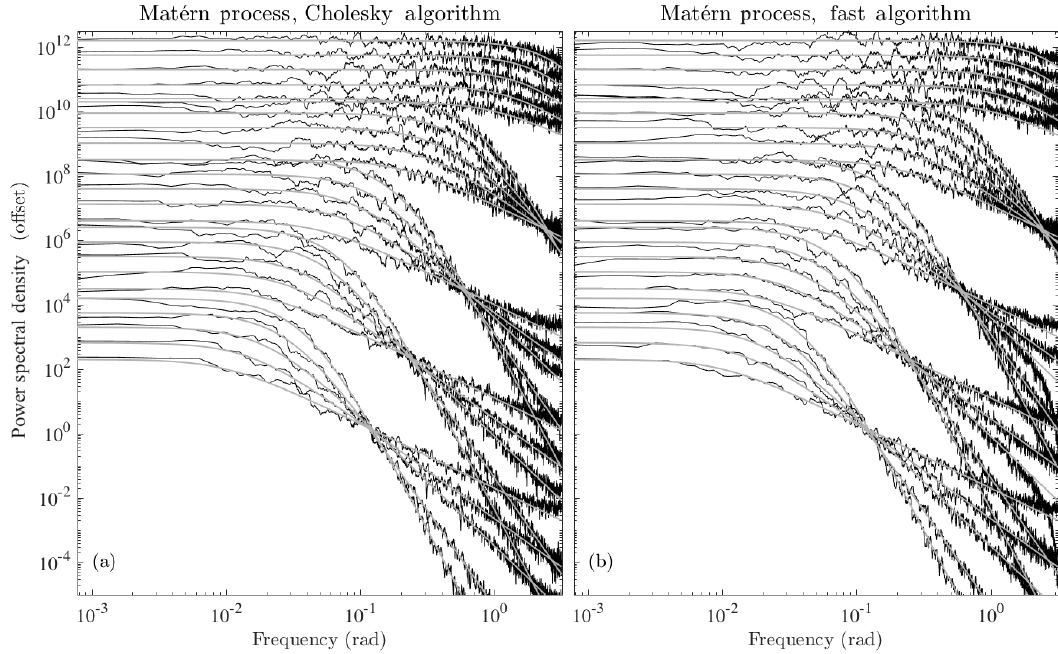
Figure 8. A comparison of the spectra of simulated unit-variance Matérn processes having 25 different (α,λ) values for (a) the Cholesky decomposition algorithm and (b) the fast generation algorithm presented here based on the Green’s function. The process samples are each 8000 points long, with the sample interval (cid:49) set to unity. Black curves show the multitaper spectral estimates, as described in the text, while gray curves are the theoretical spectral forms. Successive spectral plots have been offset in the vertical by a factor of clarity. The five lines within each group correspond to the five α values 1, 1.5, 2, 3, and 4. The five groups correspond to different values of λ , with λ equal to 0.01, 0.02, 0.05 0.2, or 1 times the value of α for each curve, proceeding from bottom to top. Only positive frequencies are shown, as the theoretical spectra at negative frequencies are identical. Simulated spectra from the O(N log N) fast algorithm in (b) and those from the O(N 3 ) Cholesky algorithm (a) are found to be virtually